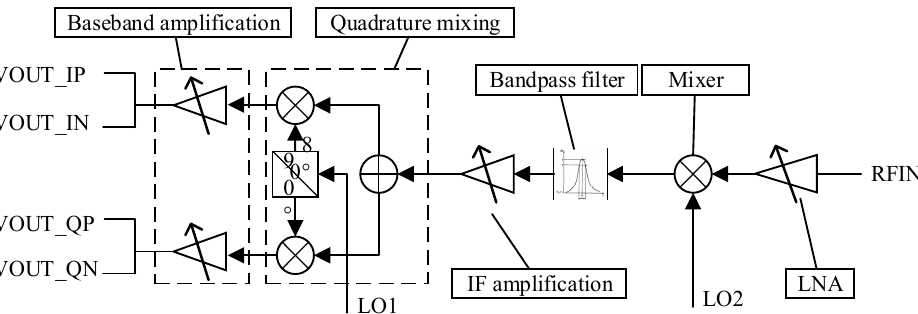
Figure 6. Block diagram of the receiving pathway principle [5–10,21].